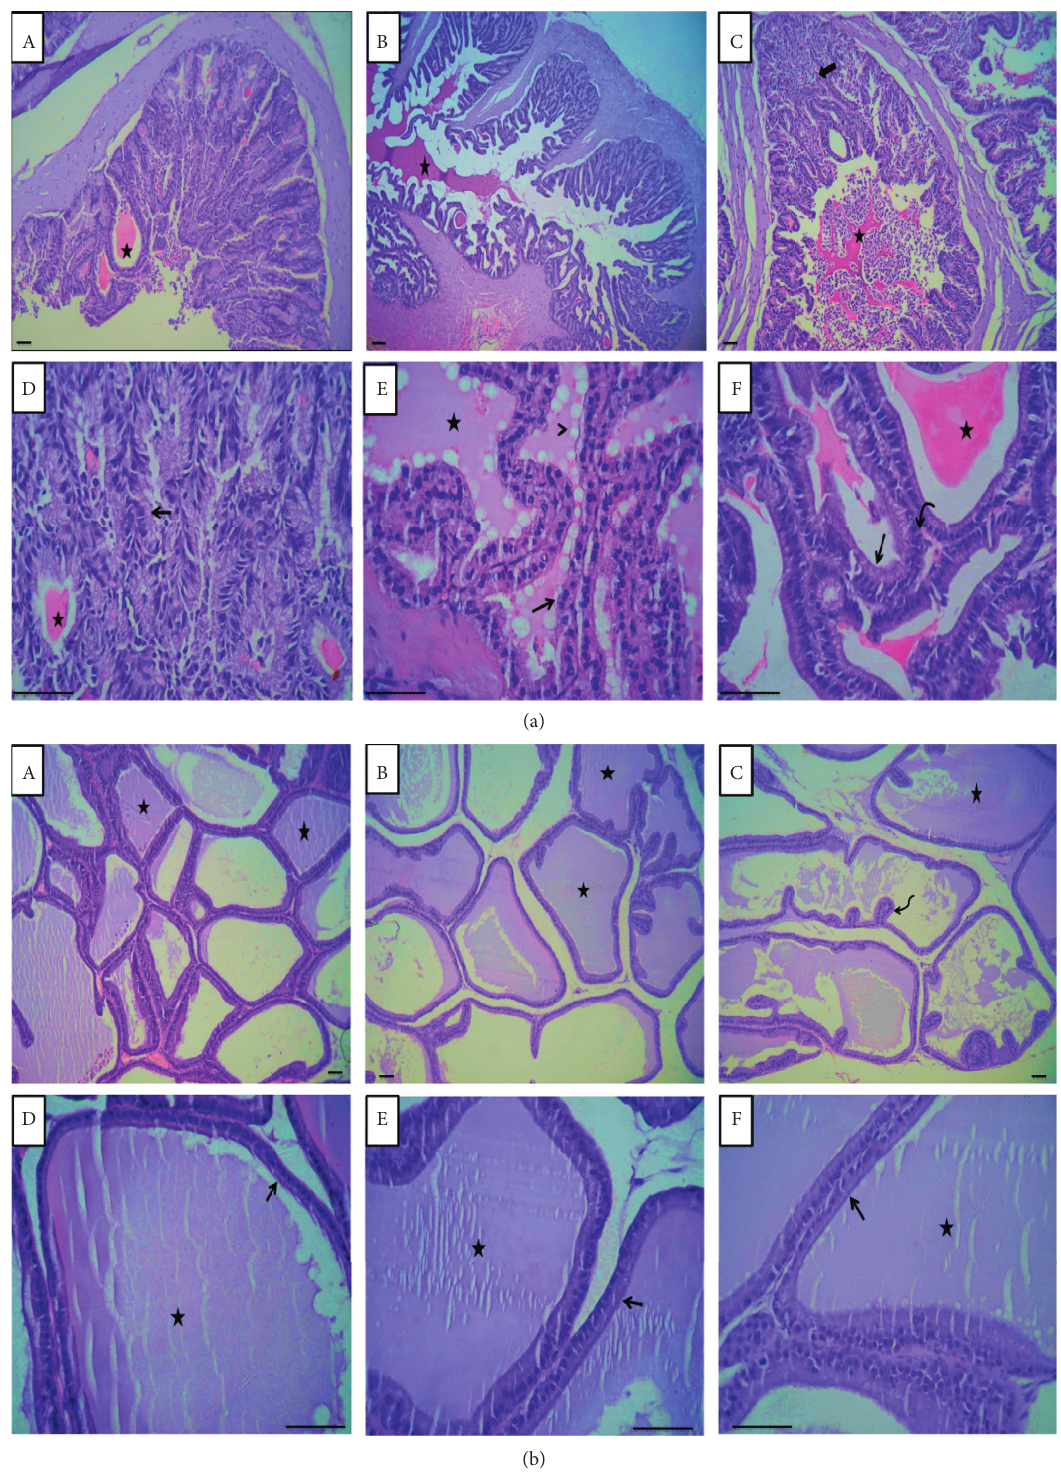
Figure 7: Histological changes in the seminal vesicles and prostates. (a) Rat seminal vesicles. (A, D) Photomicrograph of seminal vesicle of control rats showing columnar or pseudostratified columnar epithelial lining glands (arrow) and acidophilic secretory products within the glands lumina (asterisks). (B, E) Photomicrograph of seminal vesicle following prolonged light exposure illustrating pseudostratified columnar epithelial lining mucosa (arrow) and eosinophilic secretion (asterisks) with its lipoidal contents (arrow head) within glandular lumen. (C, F) Photomicrograph of seminal vesicle after prolonged dark exposure showing mild hyperplastic epithelial lining the glands (thick arrow) with columnar cells (arrow) and basal cells (curved arrow) beside accumulation of large amount of secretory materials within the glandular lumina (asterisks). (b) Rat prostates. (A, D) Photomicrograph of prostate of control rat showing cuboidal or columnar epithelial lining gland (arrow) and acidophilic secretion within the glandular lumina (asterisks). (B, E) Photomicrograph of rat prostate following prolonged light exposure showing eosinophilic inclusions in the glandular lumina (asterisks) with cuboidal or low columnar cells epithelial lining the gland (arrow). (C, F) Photomicrograph of rat prostate after prolongeddarkexposureshowing papillaryprojectionsofthemucosainto thelumenofthegland(curvedarrow), simplecolumnarepitheliallining the secretory alveoli (arrow), and eosinophilic secretions within the lumina (asterisks). Scale bar � 250 µ